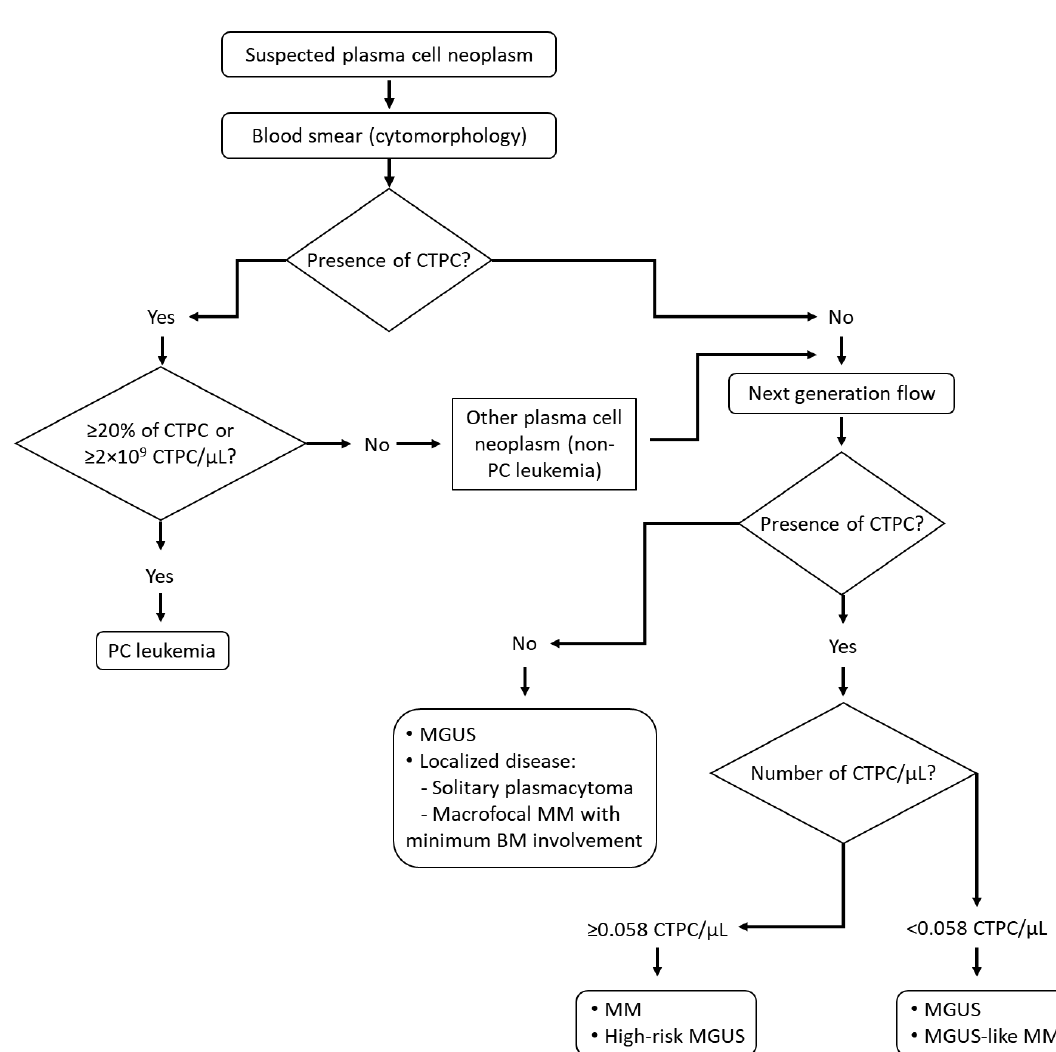
Figure 5. Proposed strategy for a comprehensive diagnostic work-up of patients suspected of or diagnosed with monoclonal gammopathy based on the assessment of circulating tumor plasma cells by complementary technologies. Please note that the proposed approach should be used in combination with currently established diagnostic approaches. BM, bone marrow; CTPC, circulating tumor plasma cells; MGUS, monoclonal gammopathy of undetermined significance; MM, multiple myeloma; PC, plasma cell.